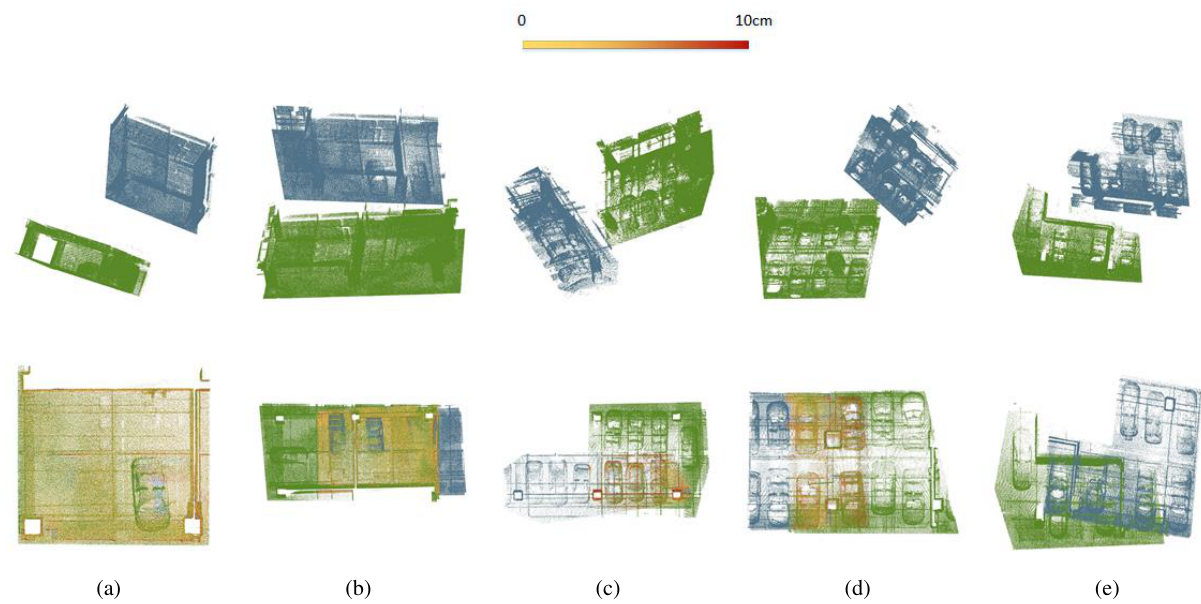
Figure 6. Different overlap scenes. The first line is the distributions of the original two point clouds. And the second line is the distributions of the point clouds after registration. (a) data overlap rate is 95%, (b) data overlap rate is 75%, (c) data overlap rate is